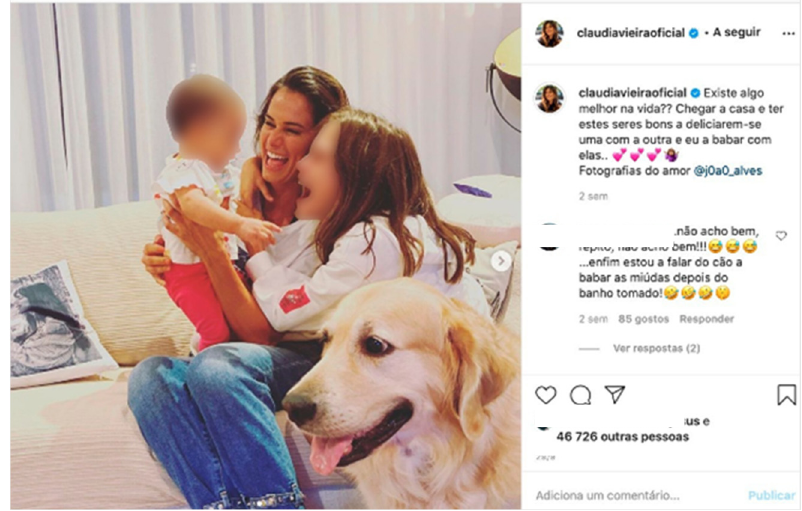
Figure 9. Example of speech—“Affection Demonstration”; @claudiavieiraoficial, Post, 29 August 2020.